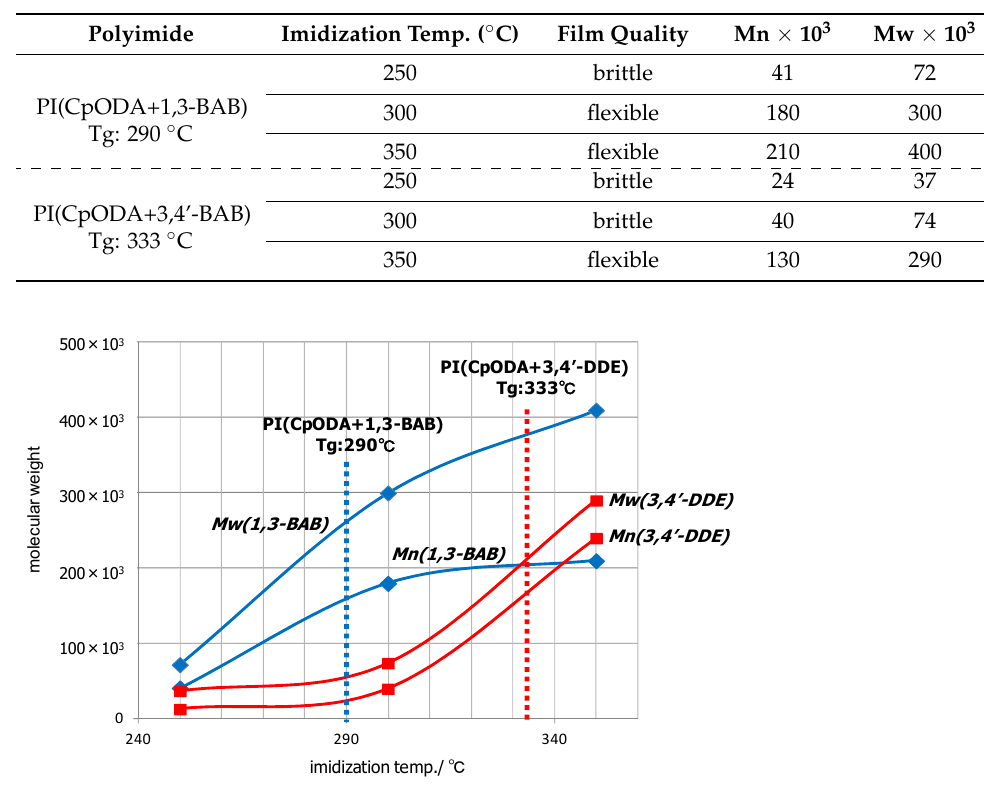
Table 1. Influence of imidization temperature on the film quality and molecular weight of the polyimide.